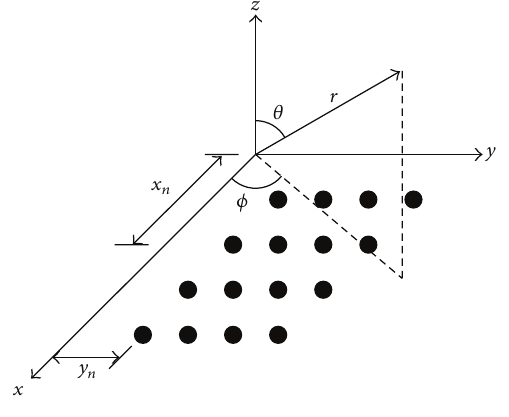
Figure 1: Planar antenna